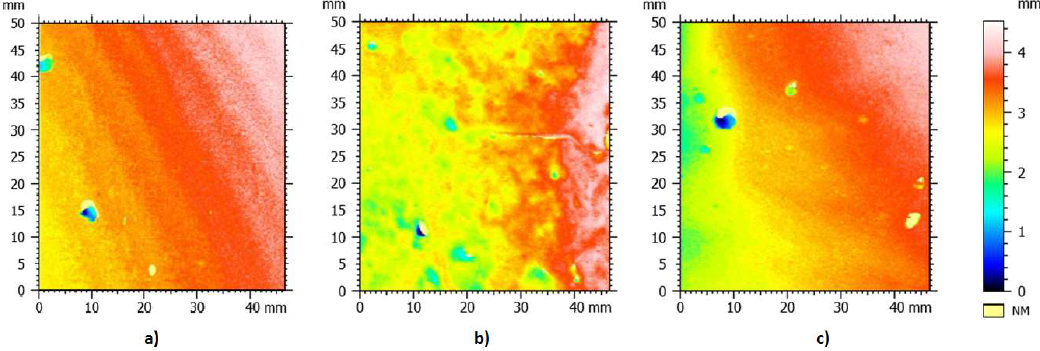
Figure 7. Surface image of samples after scanning with a laser scanner: unprepared ( a ), sanded ( b ) and grinded ( c ).